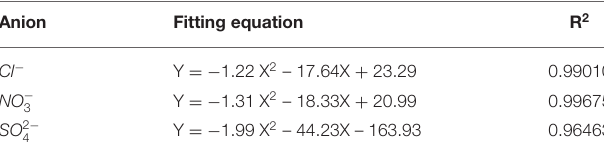
TABLE 3 | The fitting equation of anionic potential—leaching efficiency.